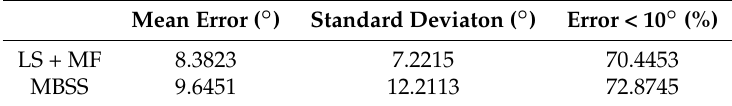
Table 4. Experimental data of muzzle blast DoA